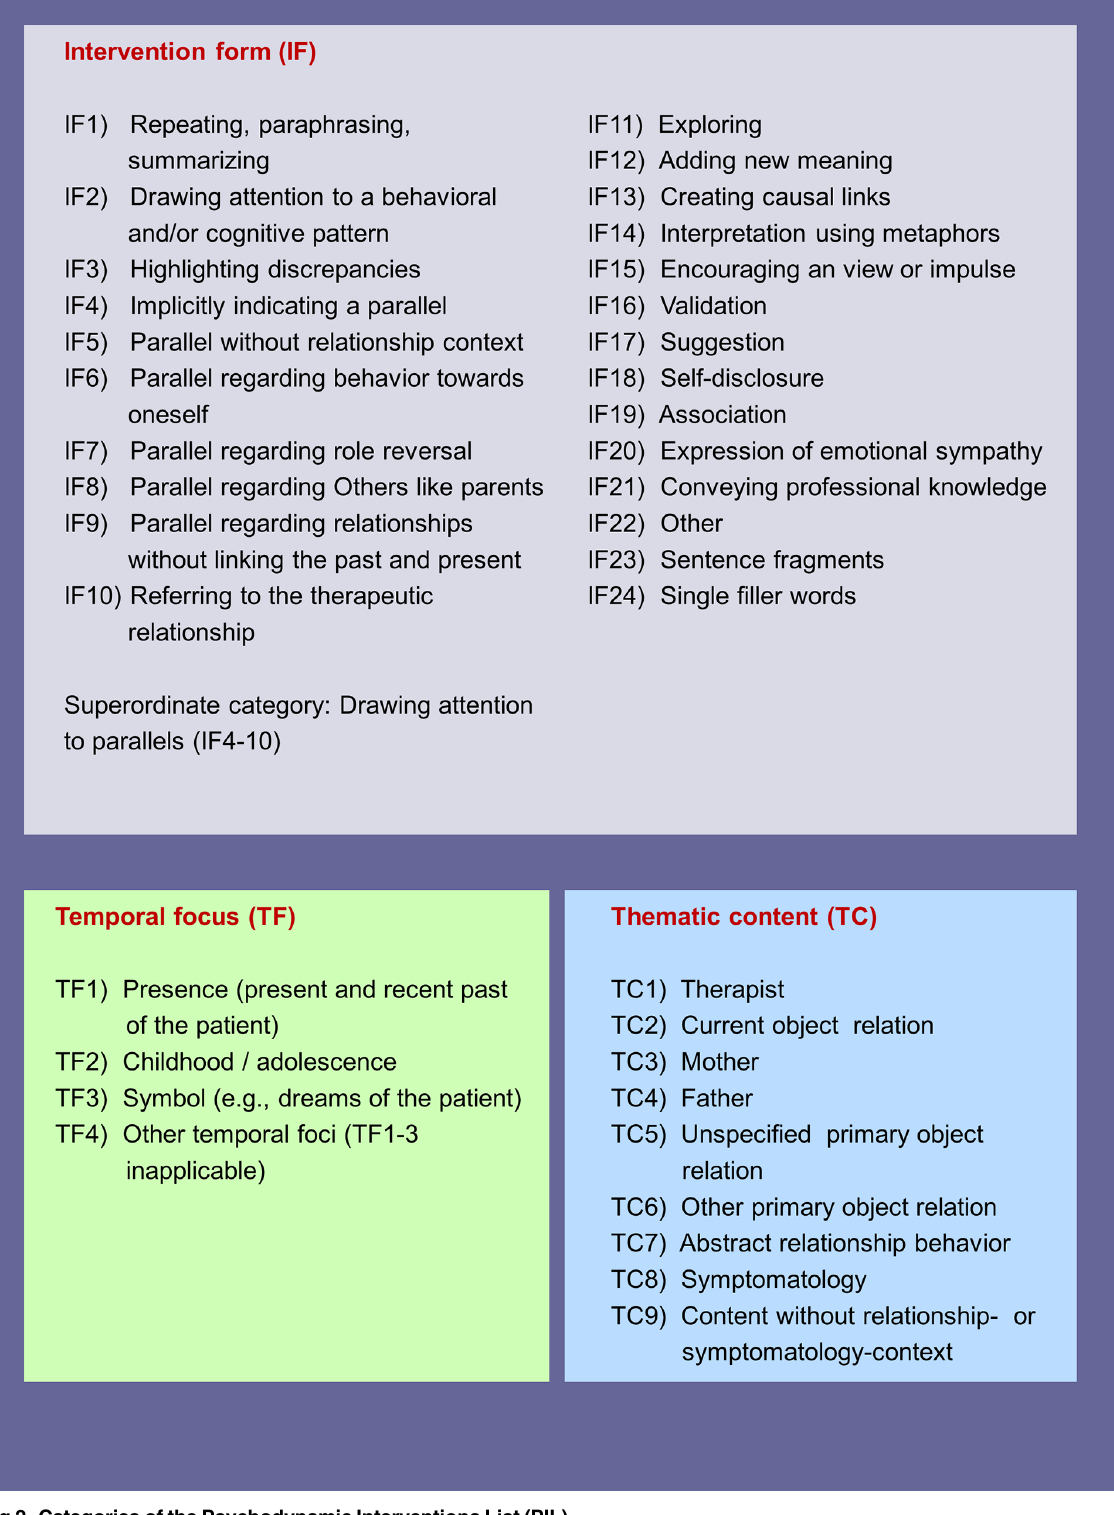
Fig 2. Categories of the Psychodynamic Interventions List (PIL).